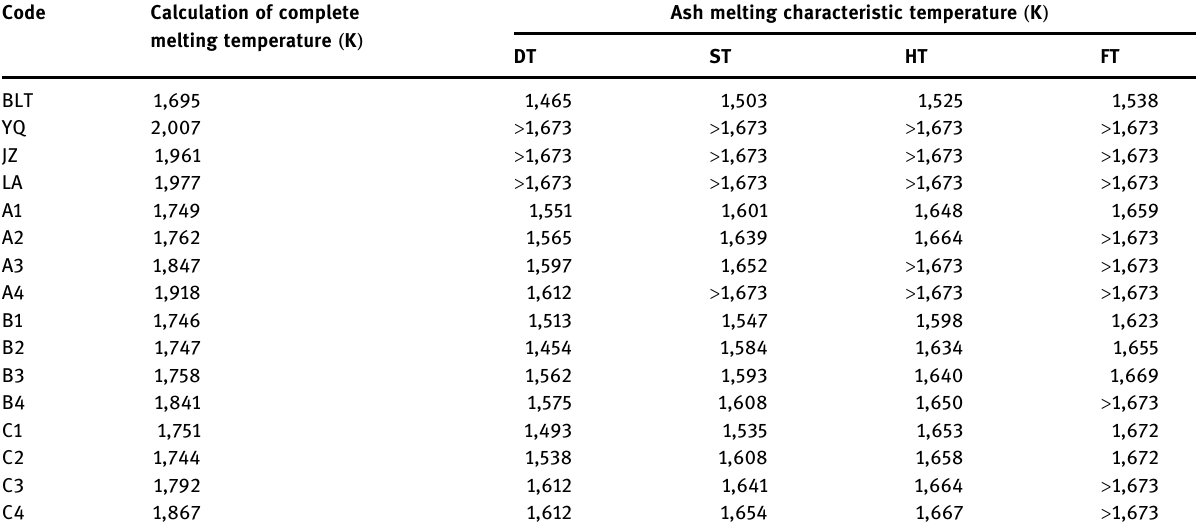
Code Calculation of